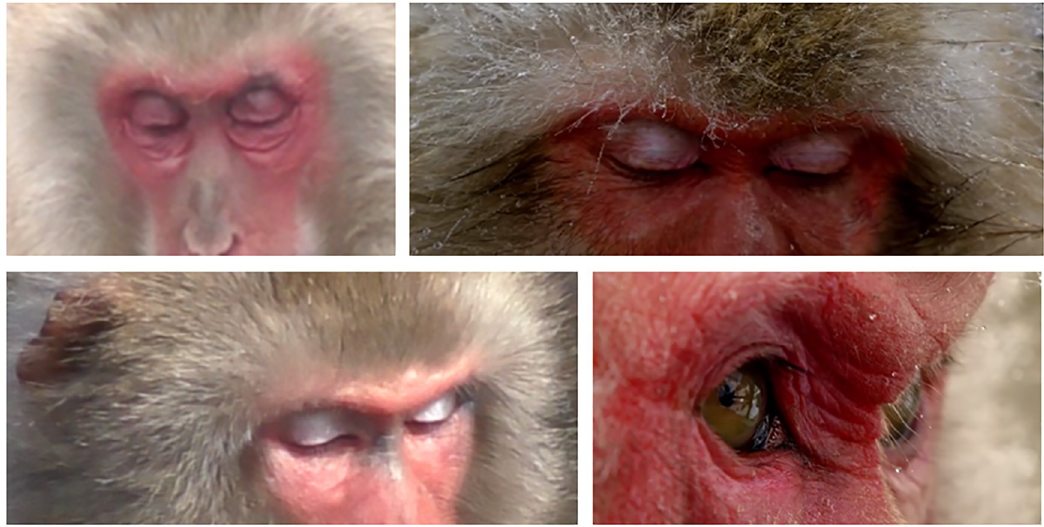
Fig 5. Variation in eye region morphology, including upper eyelid coloration and wrinkling, bulging, bagging differences around the eyes and nose